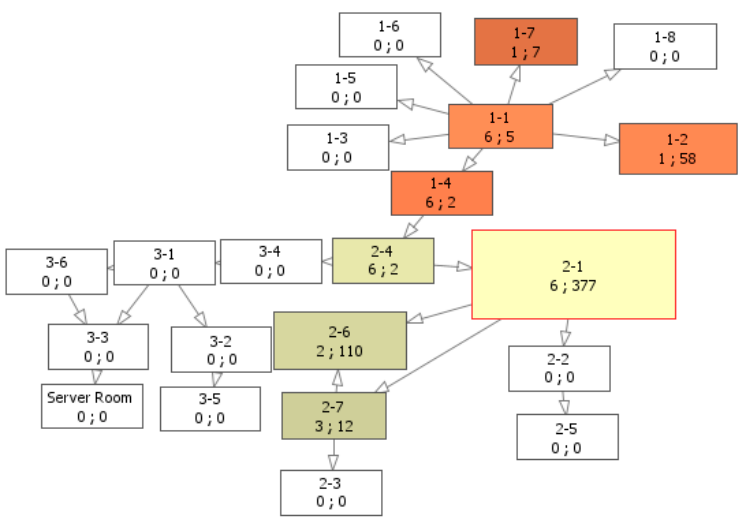
Figure 6. The graphical representation of the employees’ routes using the BandView model.